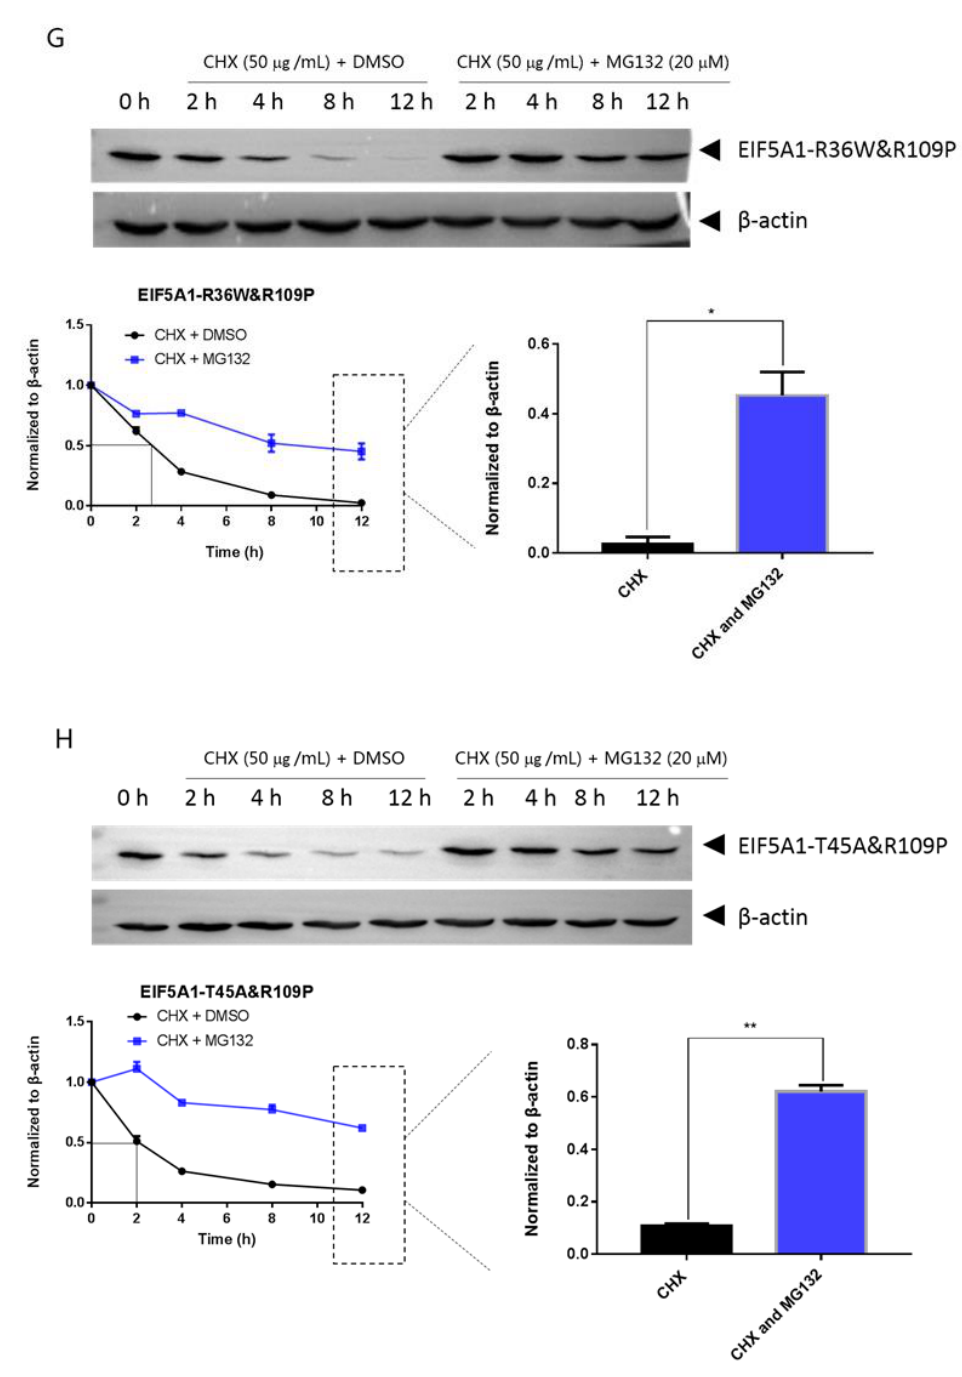
Figure 6. HeLa cells were seeded into 10 cm cell culture dishes for 24 h, transfected with EIF5A1, EIF5AL1, and EIF5A1 mutant plasmids, and the cells were averaged to nine 6 cm cell culture dishes at 24 h post-transfection. After 24 h, four of these cells were treated individually with CHX and four others with CHX and MG132. Cells were harvested after the indicated time points, and the abundance of EIF5A1, EIF5AL1, as well as EIF5A1 mutant proteins were determined by immunoblot analysis using GFP antibody. β -actin was used as the loading control. ( A ) EIF5A1 protein abundance. ( B ) EIF5AL1 protein abundance. ( C ) EIF5A1-R36W protein abundance. ( D ) EIF5A1-T45A protein abundance. ( E ) EIF5A1-R109P protein abundance. ( F ) EIF5A1-R36W&T45A protein abundance. ( G ) EIF5A1-R36W&R109P protein abundance. ( H ) EIF5A1-T45A&R109P protein abundance. ns, p > 0.05; *, p ≤ 0.05; **, p ≤ 0.01.